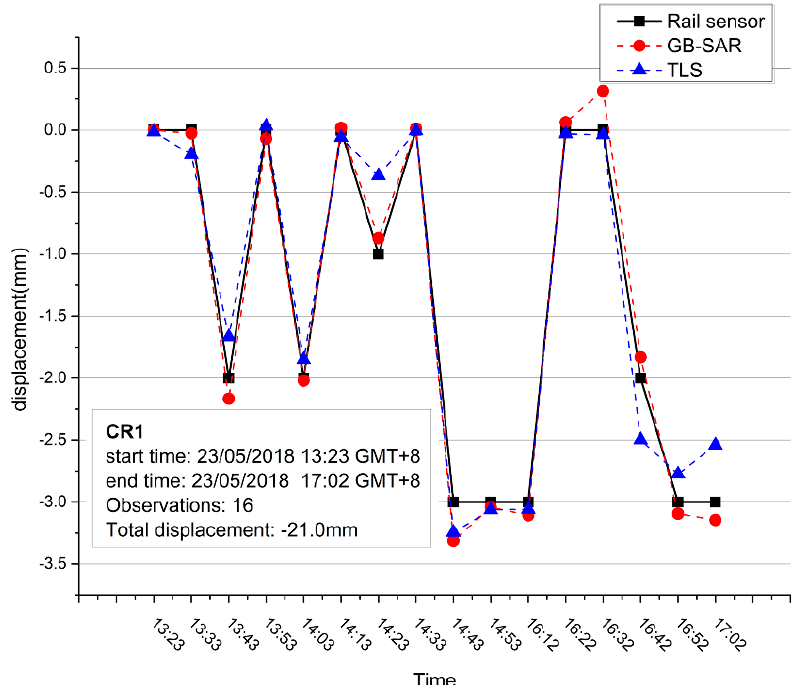
Figure 13. Comparison between rail sensor value, GB-SAR LOS interferometry, and TLS measurement.